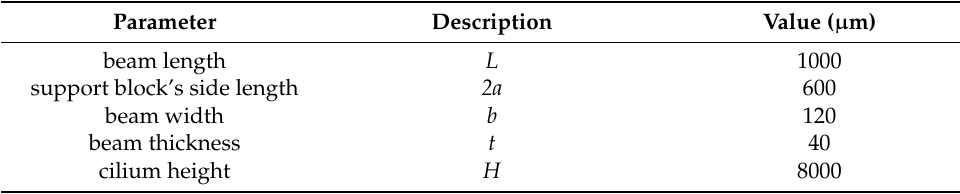
Figure 10. SEM image of the completed chip: ( a ) the 2 × 2 array and ( b ) the beam. The main parameters of FUVH are given in Table 1. Then, the processed hydrophone cross-beam chip is integrated with the same lengths of cilia [30]. Next, the integrated chip is oil-filled and packaged. Finally, the completed FUVH is shown in Figure 11.